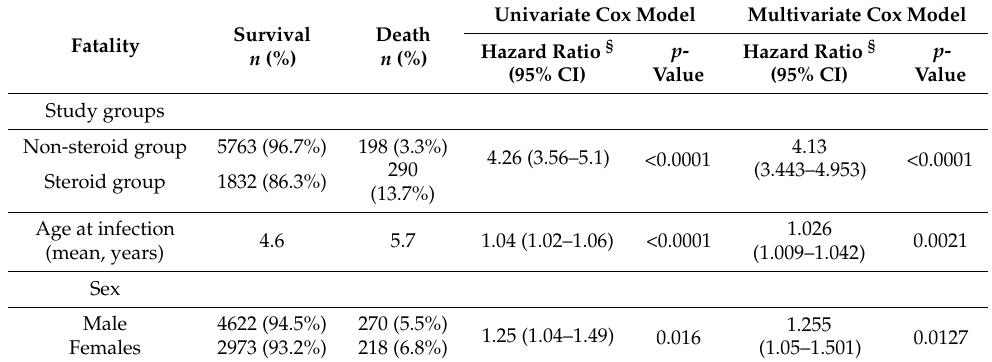
Table 6. One-year